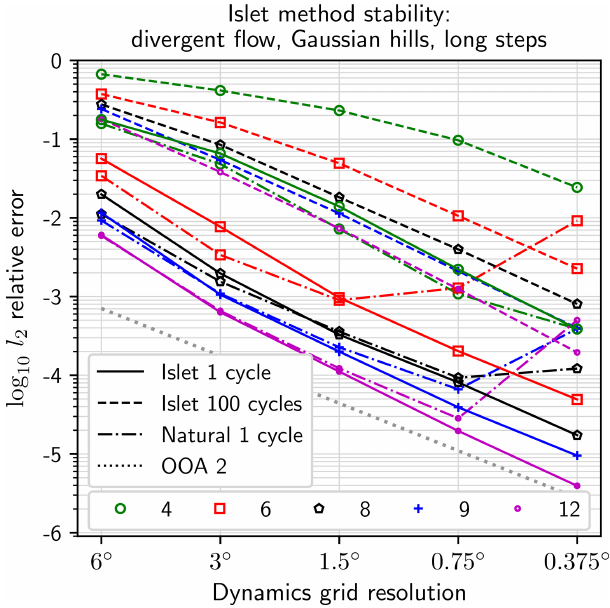
Figure A1. Stability of the Islet method with the Islet GLL bases compared with the instability of the method with the natural GLL bases. The x axis is the average dynamics-grid grid point spacing at the equator in degrees for the quasiuniform cubed-sphere grid. The y axis is log 10 l 2 relative error. A curve’s line pattern corresponds to the basis type and number of cycles, as listed in the top legend. A curve’s marker corresponds to n t p , as listed in the bottom